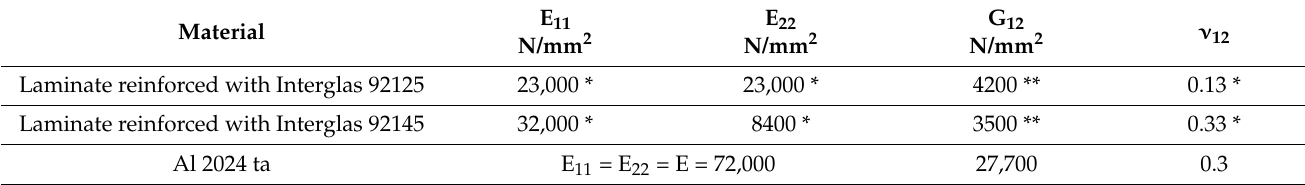
Table 1. Mechanical properties of the materials (laminates and backing metal sheet) used for manufacturing the specimens.